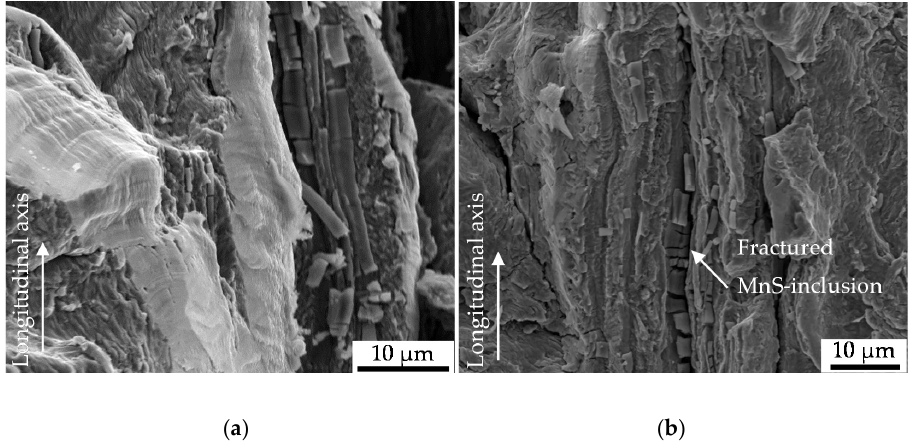
Figure 10. ( a ) Segments of cyclic damage evolution; ( b ) MnS-inclusions fractured due to cyclic damage evolution under torsional load paths.